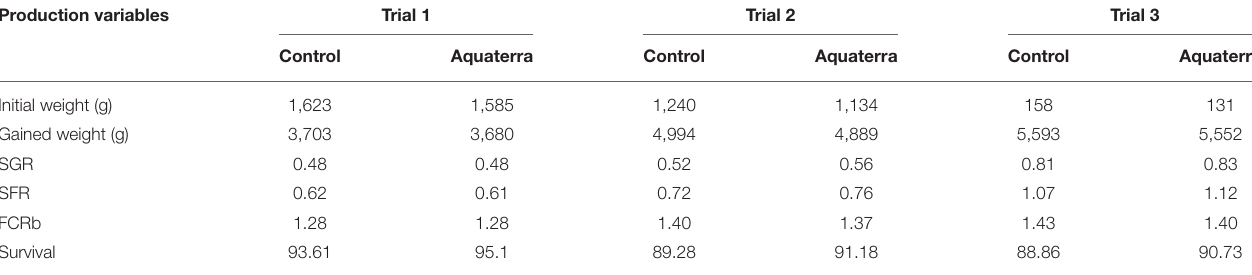
TABLE 6 | Summary of production performance in three industrial-scale fish